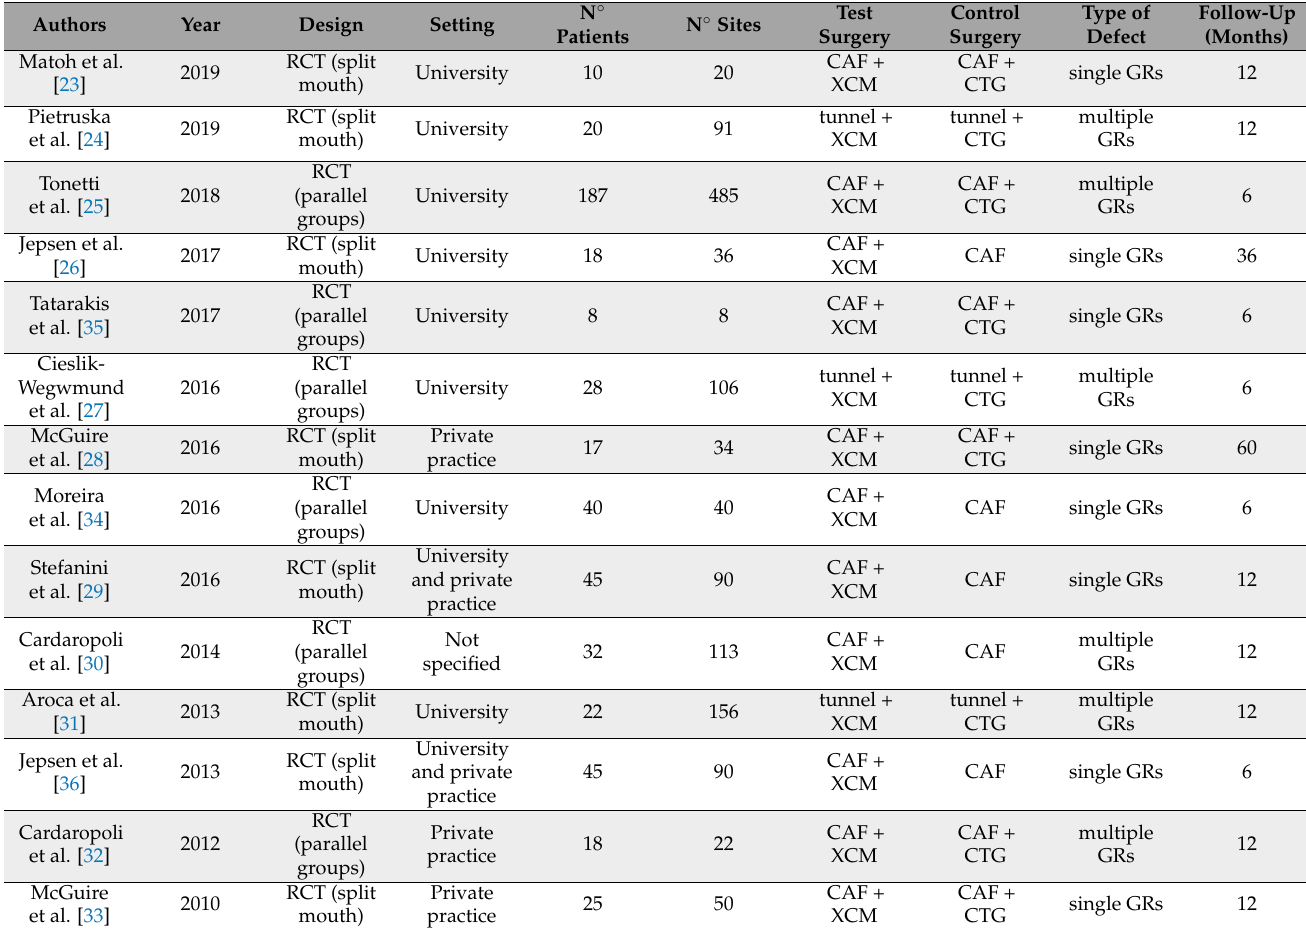
Table 1. Articles included from the study